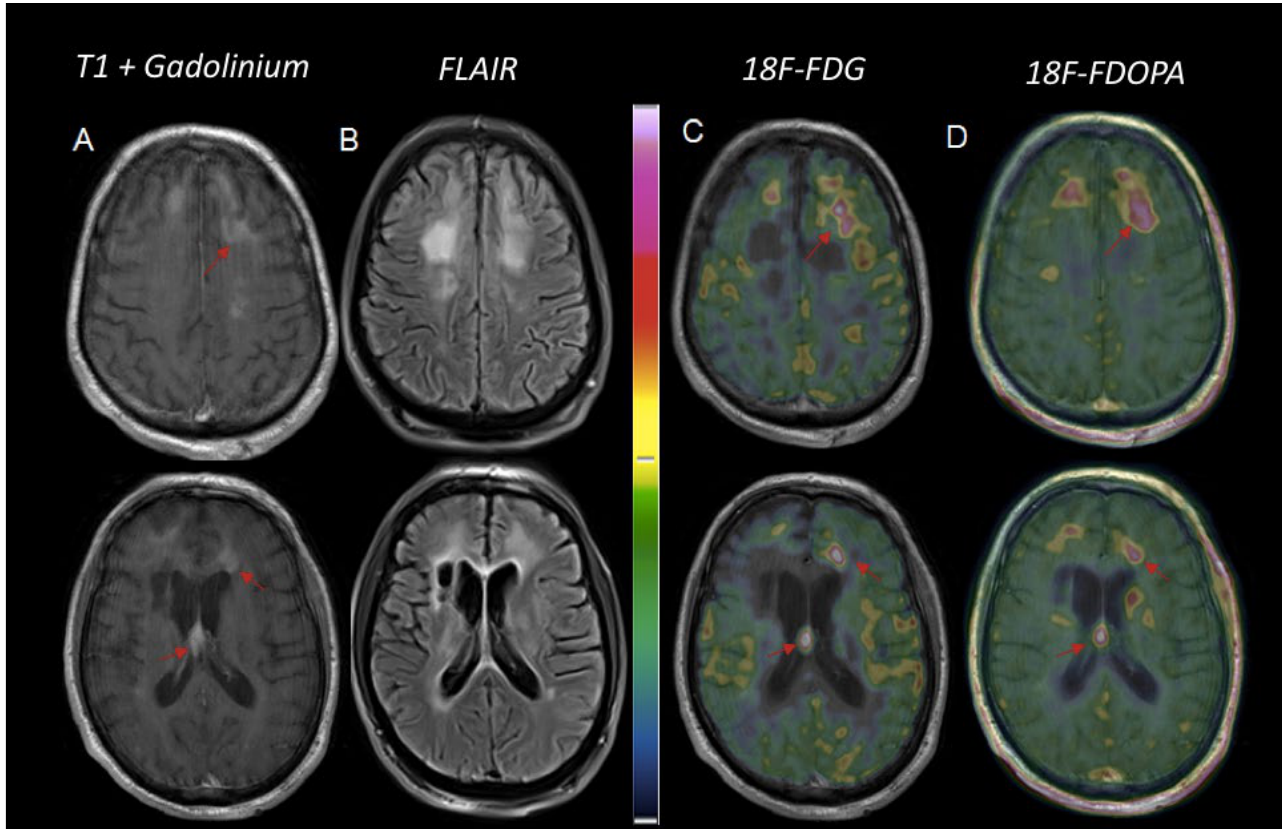
Figure 8. Illustrative case of suspicion of pseudoprogression versus progression in a 57-year-old man with IC PCNSL treated with immunotherapy (Pembrolizumab). MRI images showed suspicious bi-frontal and interventricular contrast-enhanced lesions on post gadolinium T1-weighted MRI, ( A ) and a T2-FLAIR hypersignal ( B ). Two enhanced-lesions located in the septum pellucidum and in front of the left frontal horn of the lateral ventricle, extending through the surrounding white matter, were highly hypermetabolic on 18 F-FDG PET ( C : axial PET) and showed strong uptake on 18 F-FDOPA PET ( D : axial PET): tumoral to normal contralateral tissue ratio (T/N) = 3.9 and 1.9 respectively, with 18 F-FDG versus 2.7 and 2.2 with 18 F-FDOPA. A third enhanced-lesion in the right frontal lobe showed milder uptake both on 18 F-FDG and 18 F-FDOPA PET (T/N = 1.5 and 1.8, respectively), but was considered suspicious due to its localization in white matter. Follow-up MRI confirmed the diagnosis of PCNSL relapse.